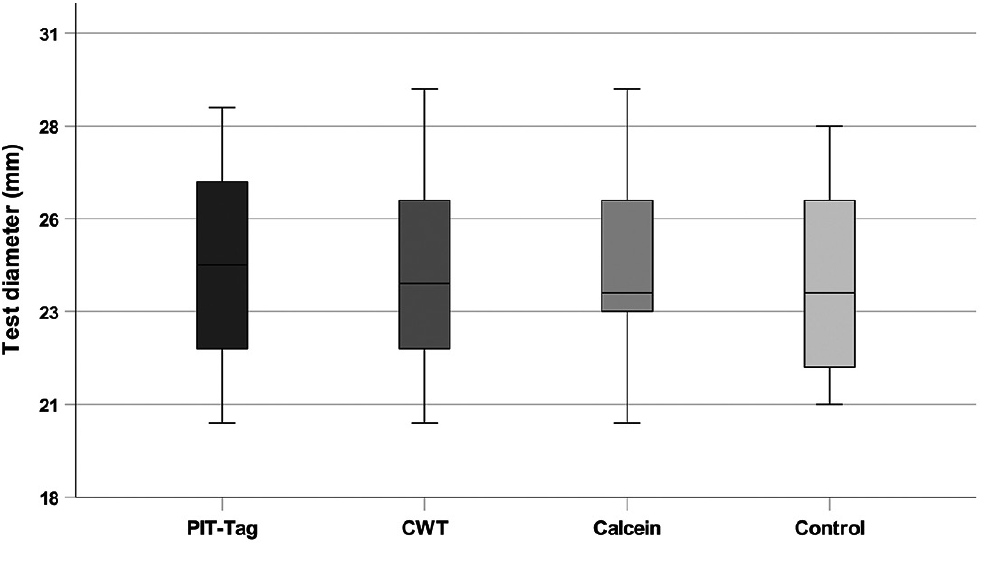
Fig. A1. – Boxplot representing the initial test diameter of Paracentrotus lividus at the beginning (T1) of a 60-day rearing in the laboratory using PIT-tags, coded wire tags (CWTs), calcein and an untagged control. The boxplot represents the minimum, maximum, median, first quartile and third quartile of the data set.